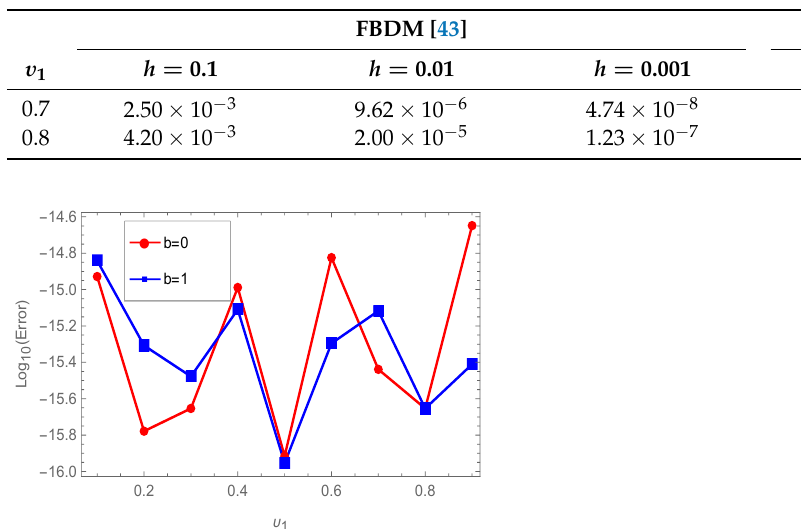
Figure 3. Comparison of Log 10 ( L ∞ − errors ) of our algorithm at b = 0 and b = 1 for N = 2 with distinct υ 1 for Example 2.